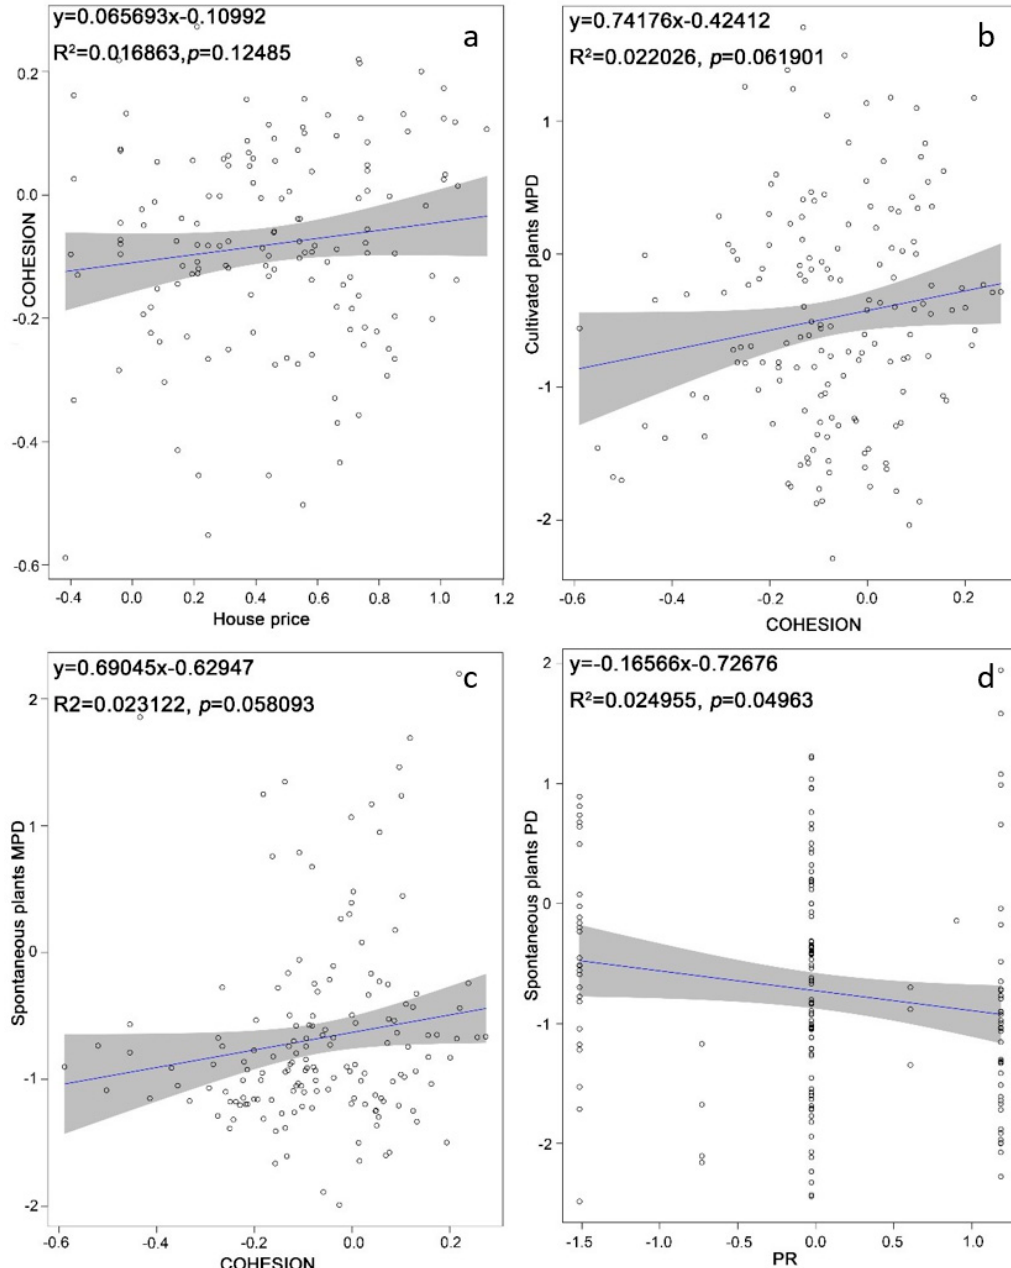
Figure 2. The results of linear regression modeling (LMs): ( a ) House price weakly affected patch cohesion; ( b , c ) Cohesion significantly affected the Mean Pairwise Distance standardized effect size (MPD.ses) of both cultivated and spontaneous plants; ( d ) Patch richness (PR) significantly affected the phylogenetic diversity standardized effect size (PD.ses) of spontaneous plants. The shaded belt shows the 95% confidence interval. The trend line illustrates the trend depicted by the regression modeling.